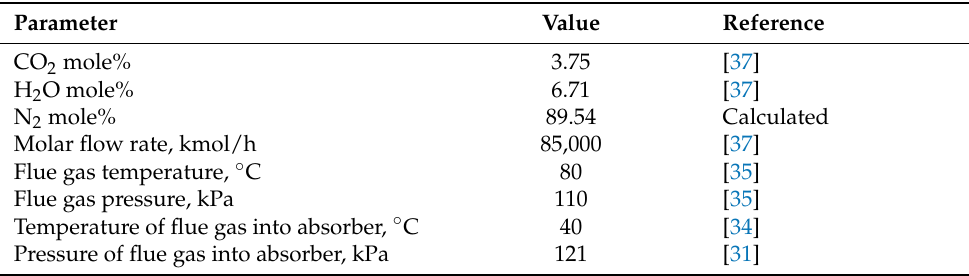
Table 1. NGCC power plant exhaust gas specification.